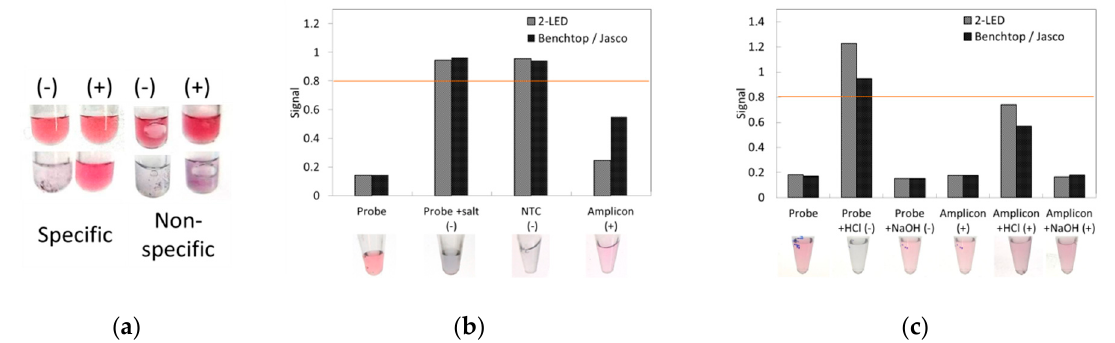
Figure 9. Colorimetric LAMP assay using non-crosslinking method for DNA detection. ( a ) Aggregation assay with specific and unspecific LAMP products using the lepB specific AuNP probe and amplicons (specific) obtained from the LepB primerset as well as amplicons (unspecific) obtained from the dotA primerset. ( b ) Absorption ratio mean values: salt-induced method and corresponding tube images, obtained after 15 min. ( c ) Absorption ratio mean values: pH induced method and corresponding tube images obtained after 15 min. Horizontal line: threshold value. NTC, negative template control.